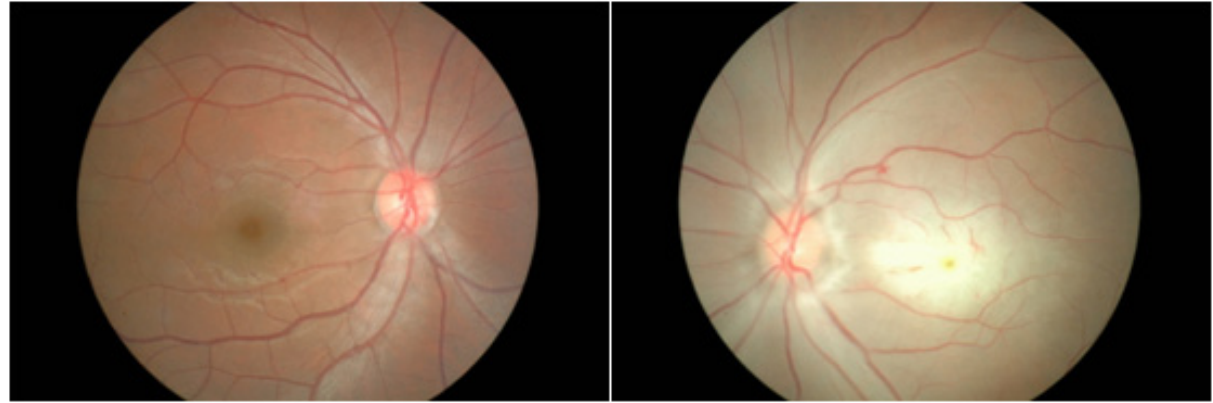
Figure 2. Fundus photograph showing the outer retinal ischemia minimally subsided, as seen by decreased swelling and reddish fundus, and still perifoveal whitening of the inner retina in the left